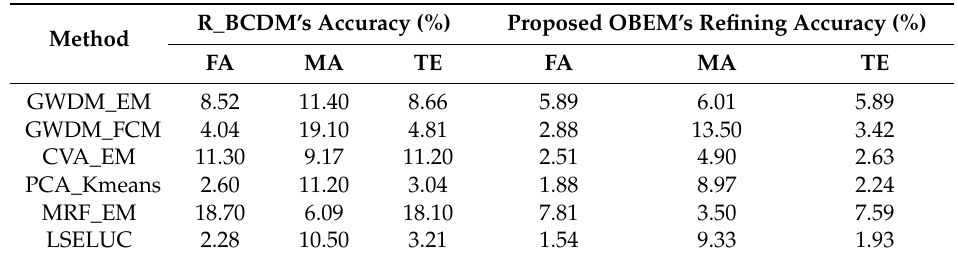
Table 4. Comparison between existing preprocessing methods and the OBEM post-processing approach for the first data set (aerial images with 0.5 m/pixel resolution).